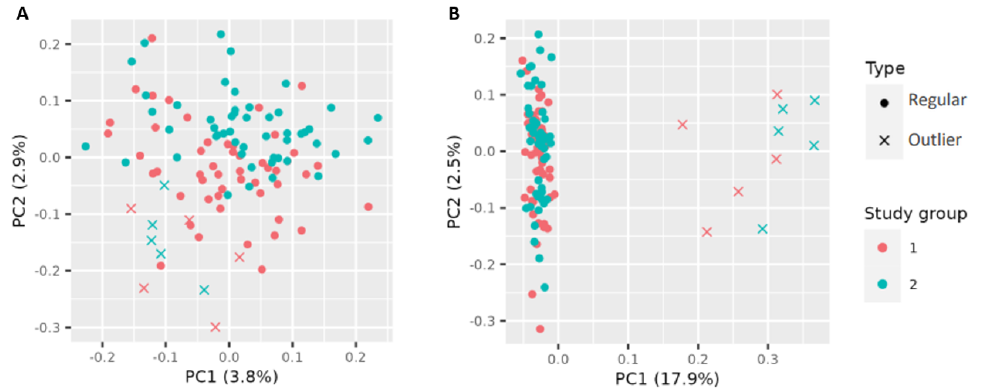
Figure 3. Examples of sample distributions in the space of the first two principal components from two selected simulation runs. In each simulation run, 50 samples per study group were generated plus 5 outlier samples per group. In some simulation runs, outliers were close to the regular samples of the study groups ( A ), and in other runs, outliers were more distant from the true groups ( B